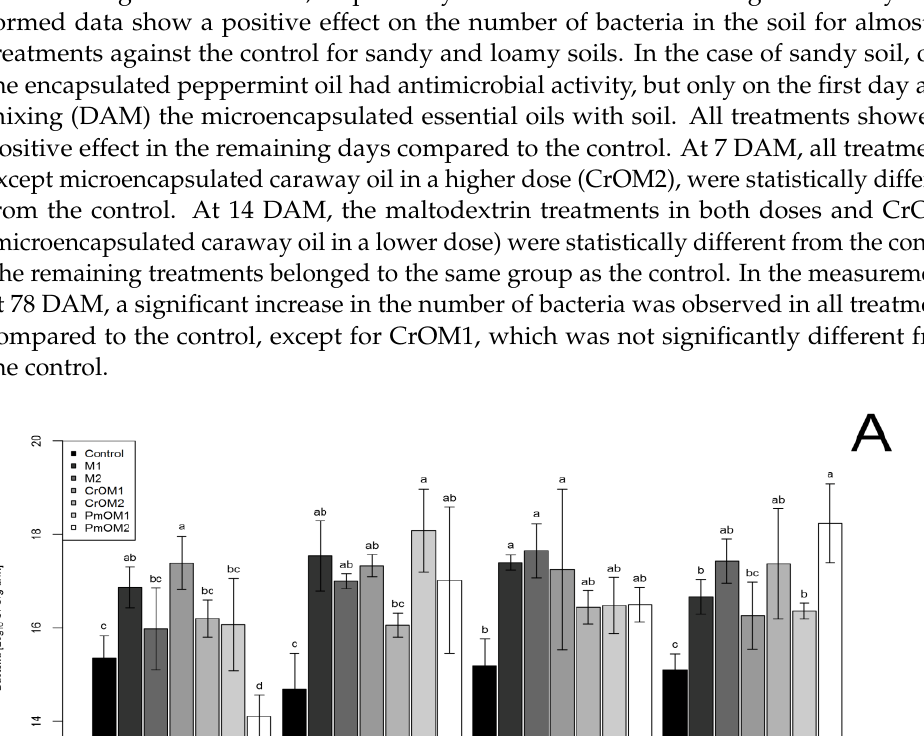
Figure 1. The abundance of bacteria in sandy ( A ) and loamy ( B ) soils depending on different treatments with maltodextrin (M1 and M2) and encapsulated essential oils of caraway (CrOM1 and CrOM2) and peppermint (PmOM1 and PmOM2). 1 and 2 refer to doses of microcapsules, 50 and 200 g per 1 kg of soil, respectively. Letters on error bars denote statistical significance among groups according to Duncan’s MLR post hoc test at level p < 0.05. 2.2. Effects on Fungi The results shown in Figures 2A and 2B, respectively and in Table S2, present the effects of different treatments on the growth of fungi in sandy and loamy soil, respectively. In the case of sandy soil, fungal abundance did not change compared to the control, but in some cases, an inhibitory effect was observed. In all measurement sections, PmOM2 affected the inhibition of fungal growth. At 1 DAM, only PmOM2 was statistically different from the control, showing a significant inhibitory effect on fungal growth. At 7 DAM, a low dose of maltodextrin in each combination (M2, CrOM2, and PmOM2) showed almost total inhibition of fungal growth, while the other treatments were the same as the control. In the measurements at 14 DAM, M2 and PmOM2 also inhibited fungal growth, while the other treatments had no effect compared to the control. At 78 DAM, the number of fungi was almost the same as on the first DAM, with the inhibitory effect of PmOM2 and the other treatments, which did not affect the growth of fungi compared to the control. In the case of loamy soil, inhibition of fungal growth was observed at 1 and 7 DAM, while, in the remaining measurement days, most treatments had a stimulating effect on the growth of fungi. At 1 DAM, both doses of maltodextrin (M1 and M2) and peppermint oil (PmOM1 and PmOM2) showed inhibition of fungal growth, while other treatments had no effect compared to the control. Results for all treatments, at 7 DAM, were as for